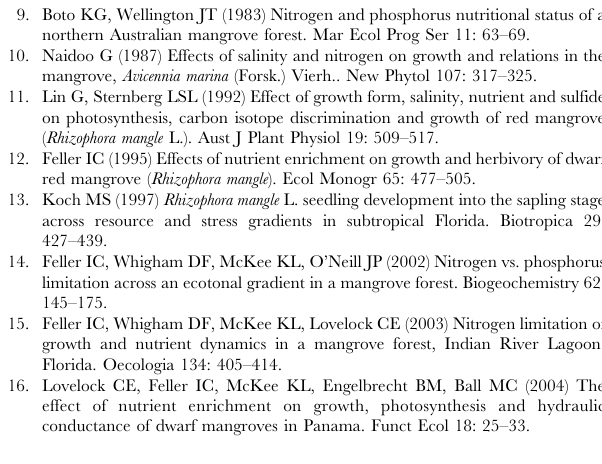
Figure S1 Death of experimental mangrove trees over fertilization treatments and over rainfall and porewater salinity gradients. Mortality increased with decreasing average annual rainfall and increasing porewater salinity. Trees fertilized with Nitrogen ( + Nitrogen) show more pronounced sensitivity to rainfall and salinity than trees fertilized with phosphorus ( + Phosphorus) and trees that were not fertilized (Control). Analysis by logistic regression indicates significant fertilization treatment x rainfall (P=0.001) and fertiliza- tion treatment x salinity (P=0.025) effects on mortality. Found at: doi:10.1371/journal.pone.0005600.s001 (8.71 MB TIF)